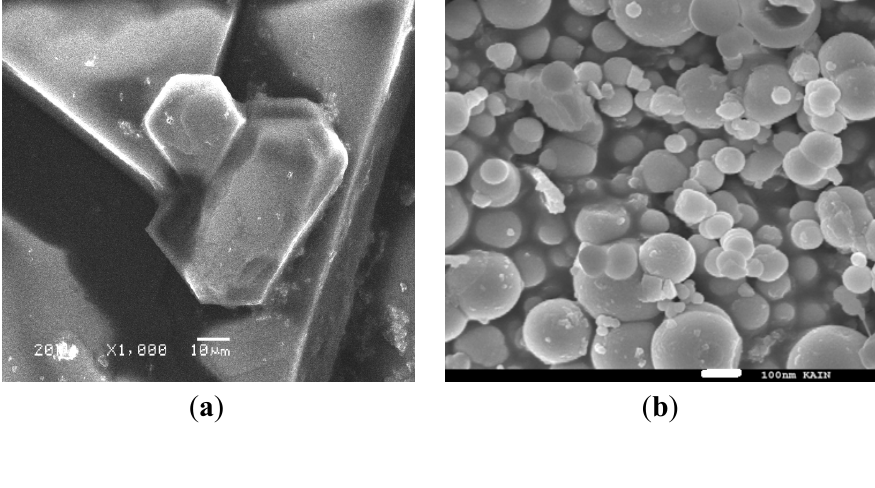
(2,9-dimethyl-1,10-phenanthroline)·H 2